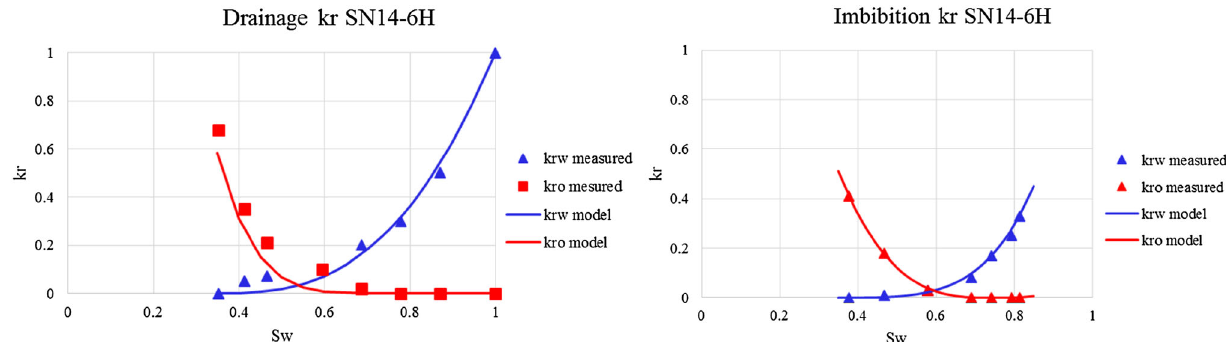
Fig. 26 Drainage and imbibition K r correlation for